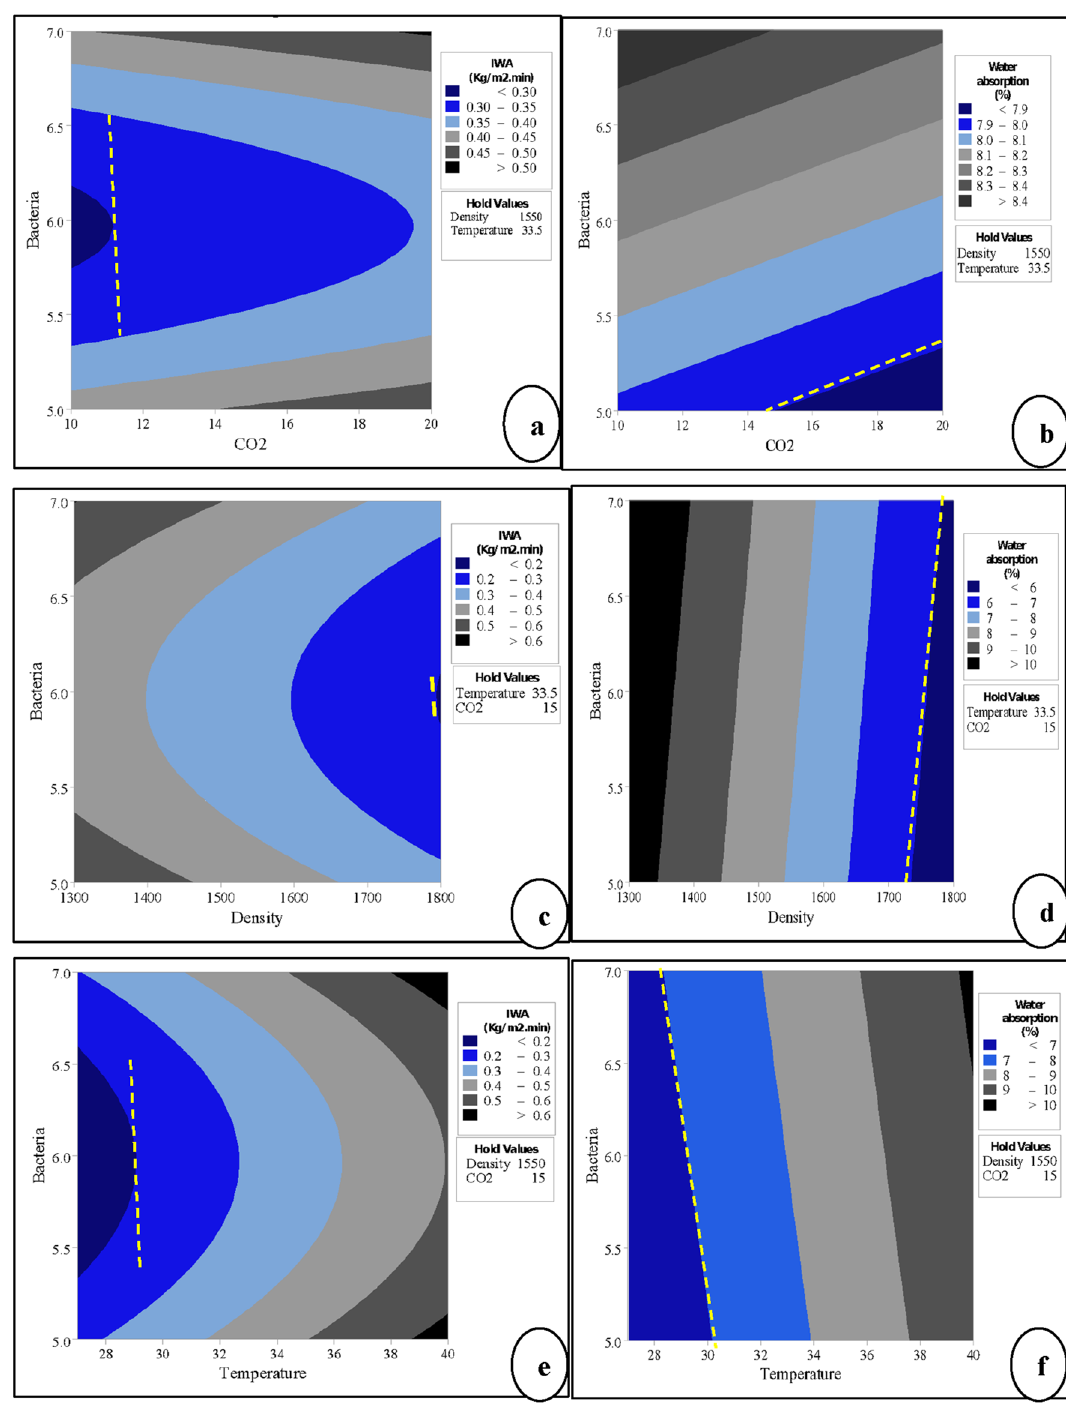
Figure 11. Counter plots of the responses with different factors ( a , c , e ) counter plots for IWA and ( b , d , f ) counter plots for